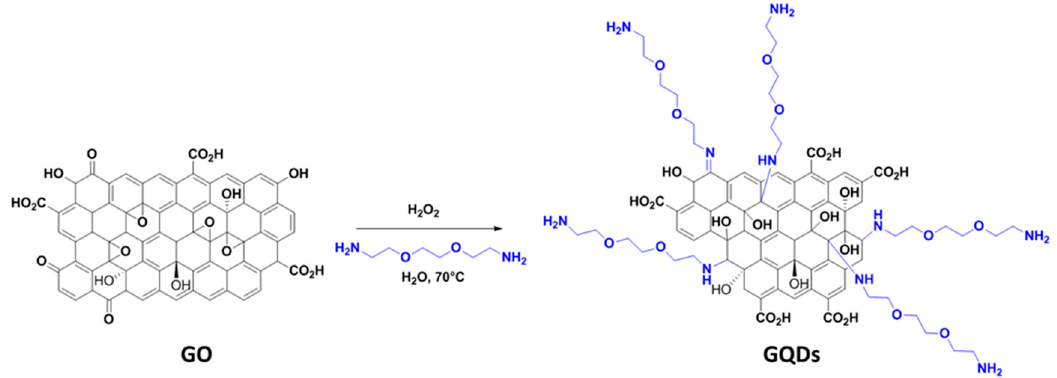
Figure 1. Schematic illustration of graphene quantum dots (GQDs) synthesis from graphene oxide (GO).